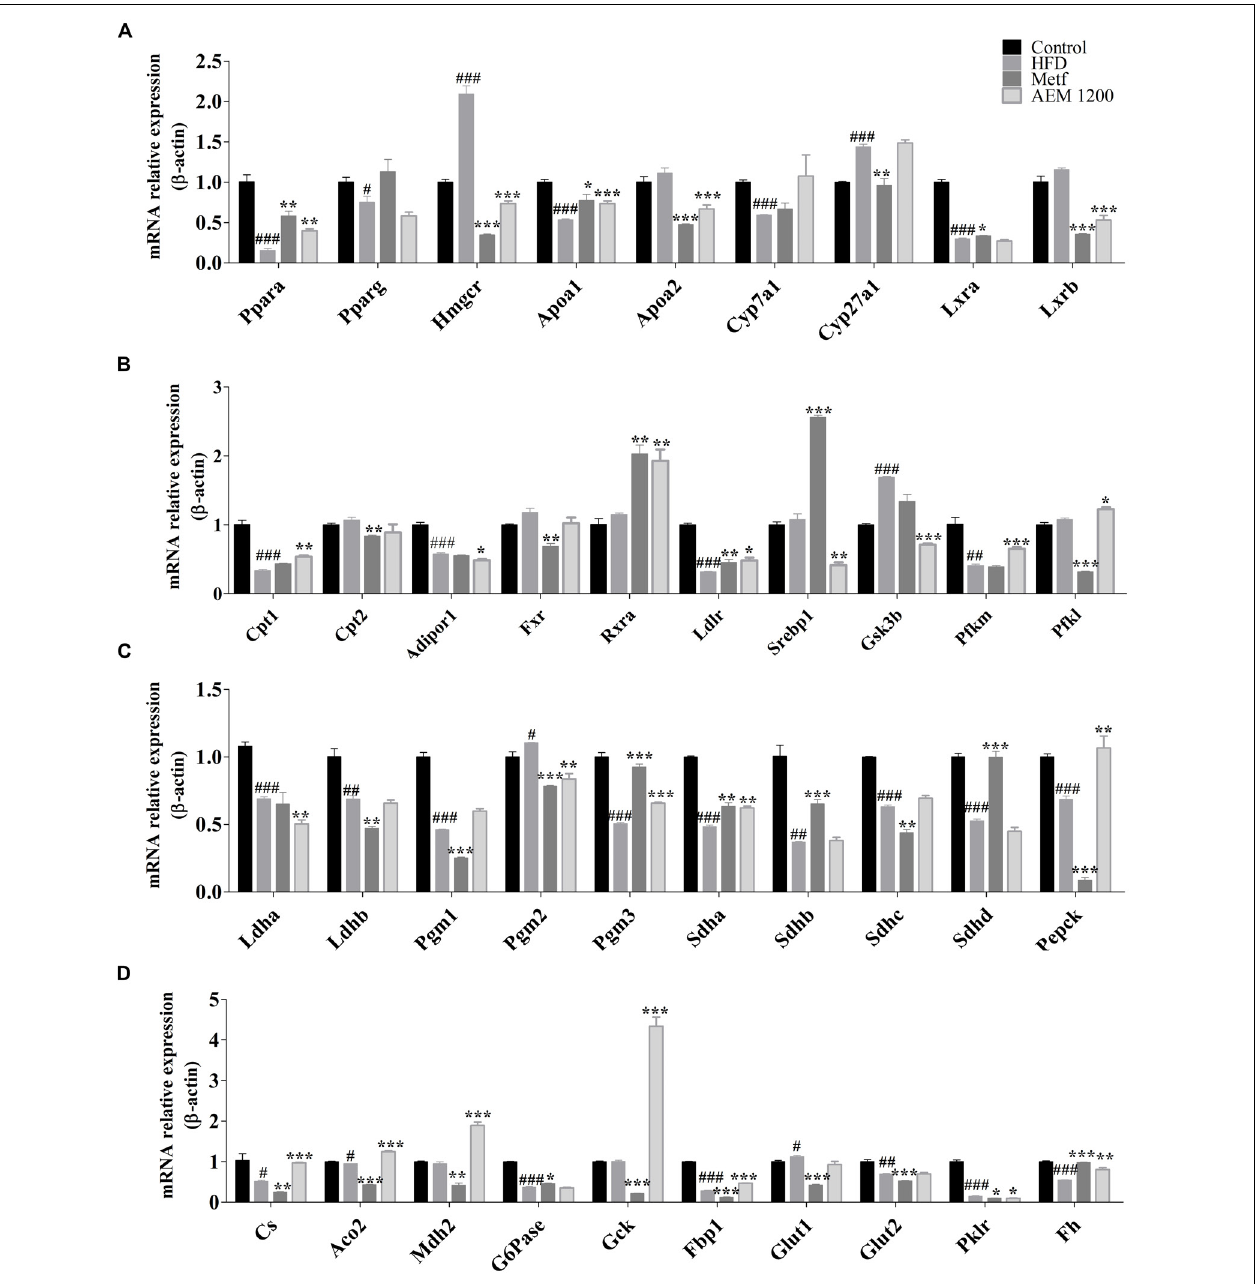
FIGURE 4 | (A–D) mRNA expression levels of hepatic genes involved in lipid metabolism and the glycolysis/gluconeogenesis-TCA cycle. The mRNA levels were determined using quantitative real-time PCR and were normalized to β -actin mRNA expression. Data are presented as the means ± SEMs. # P < 0.05, ## P <